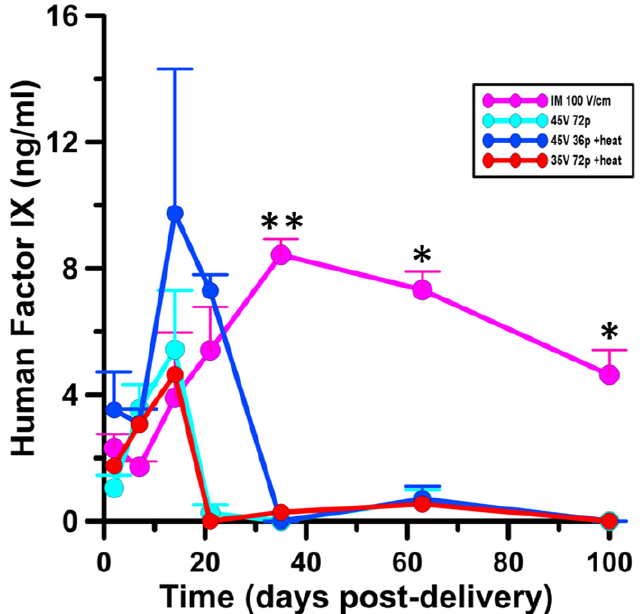
Figure 8. Factor IX expression following moderate heat-assisted and intramuscular GET. Human Factor IX in guinea pig serum. The data represent the average ± SEM, n = 5 individuals per group. * p < 0.05, ** p < 0.01.